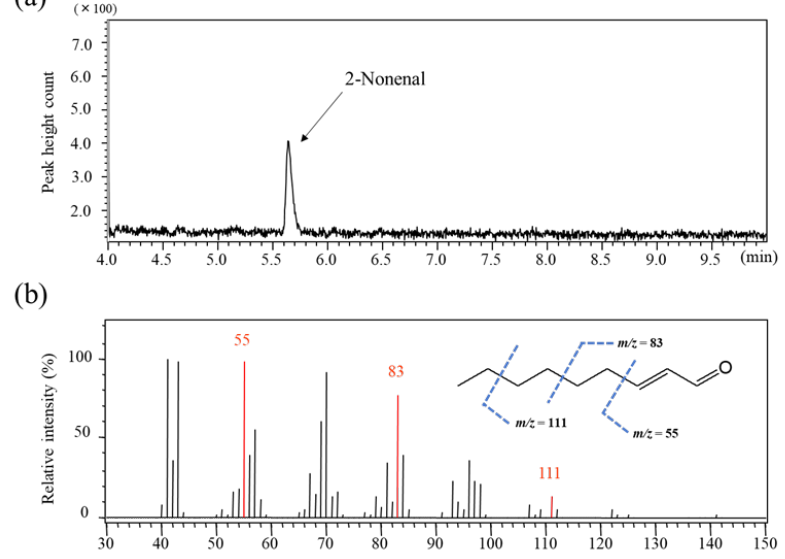
Figure 1. Chromatogram ( a ) and mass spectrum ( b ) obtained from standard 2-nonenal. The dotted lines in the structure represent the fragments of 2-nonenal.